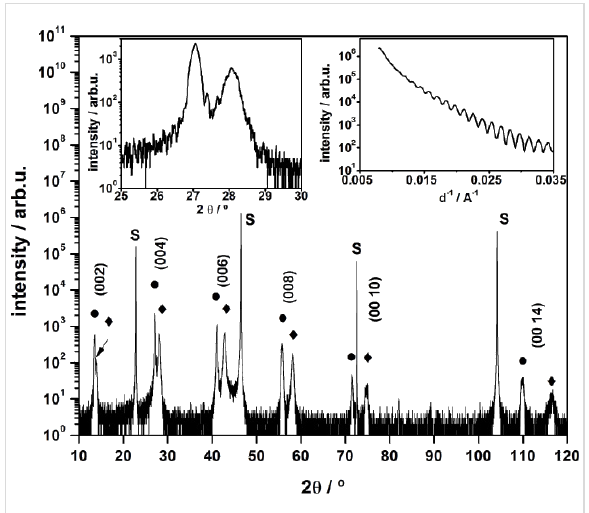
Figure 5: XRD θ –2 θ scan of a bilayer heterostructure La 2 NiO 4 (diamonds)–La 2 CuO 4 (circles) on a STO(100) substrate (S). The thick- ness of the La 2 NiO 4 and La 2 CuO 4 is 26 nm and 40 nm respectively, according to the number of RHEED oscillations recorded during the growth. In the left inset: magnification of the (004) diffraction peak; in the right inset: XRR scan.